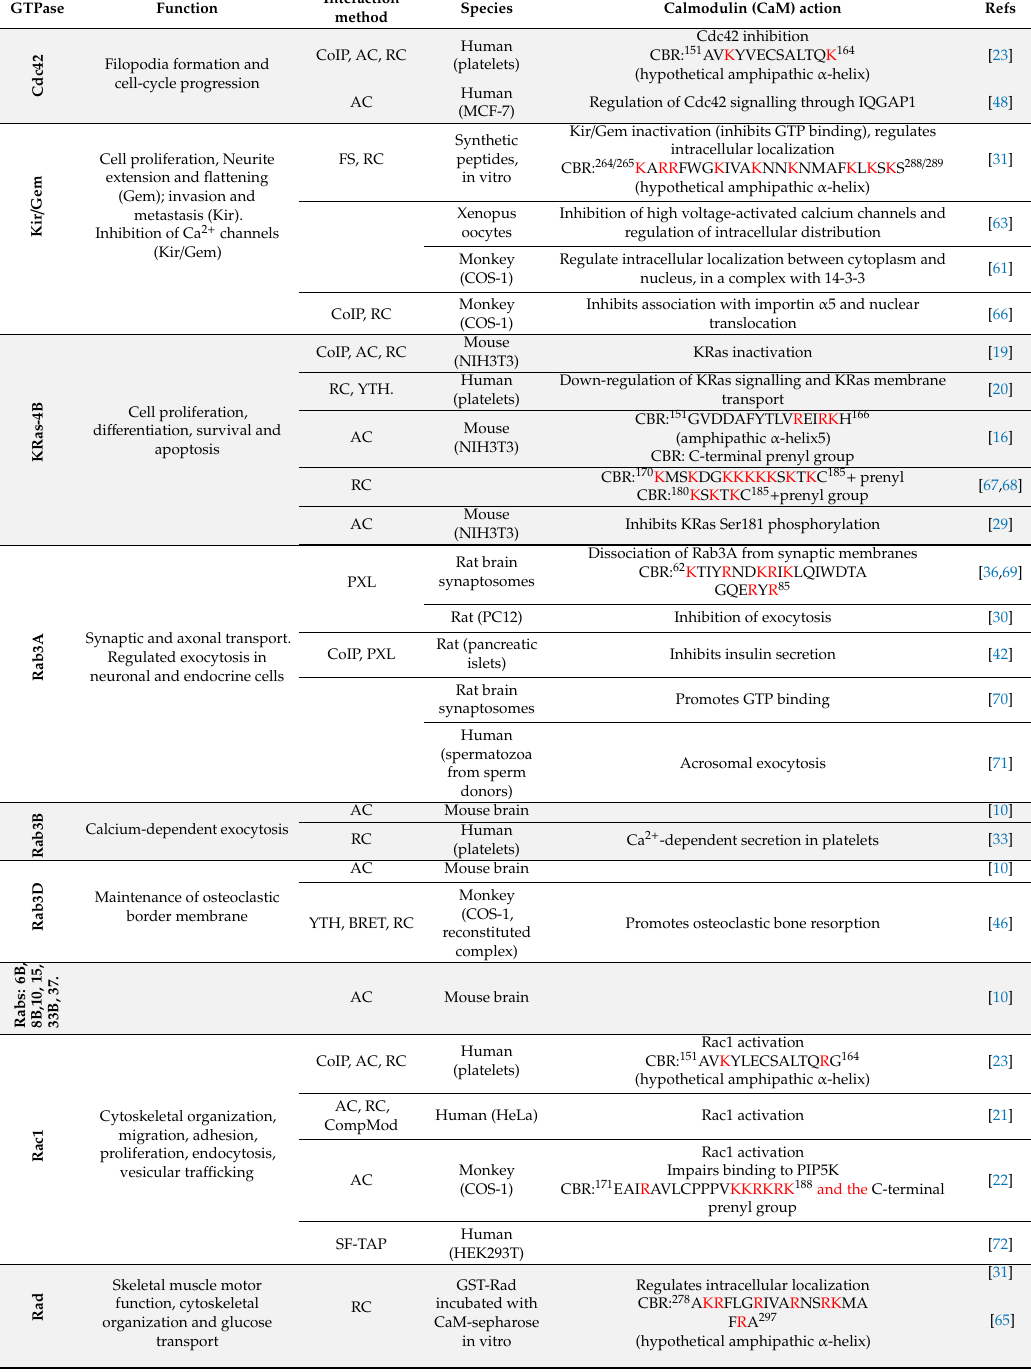
Table 1. Small GTPases interacting with calmodulin. The various GTPases, their functions, the methodologies to assess their interaction with calmodulin, the cell lines analyzed, the calmodulin function as well as their interacting domains or protein sequences are listed. The relevant references are also given. Abbreviations: AC, affinity chromatography; BRET, bioluminescence resonance energy transfer; CBR, calmodulin binding region (basic amino acids are in red); CoIP, coimmunoprecipitation; CompMod, computational modelling; FS, fluorescence spectrometry; PXL, peptide cross-linking; RC, reconstituted complex; SF-TAP, Strep / Flag tandem affinity purification; YTH, yeast two